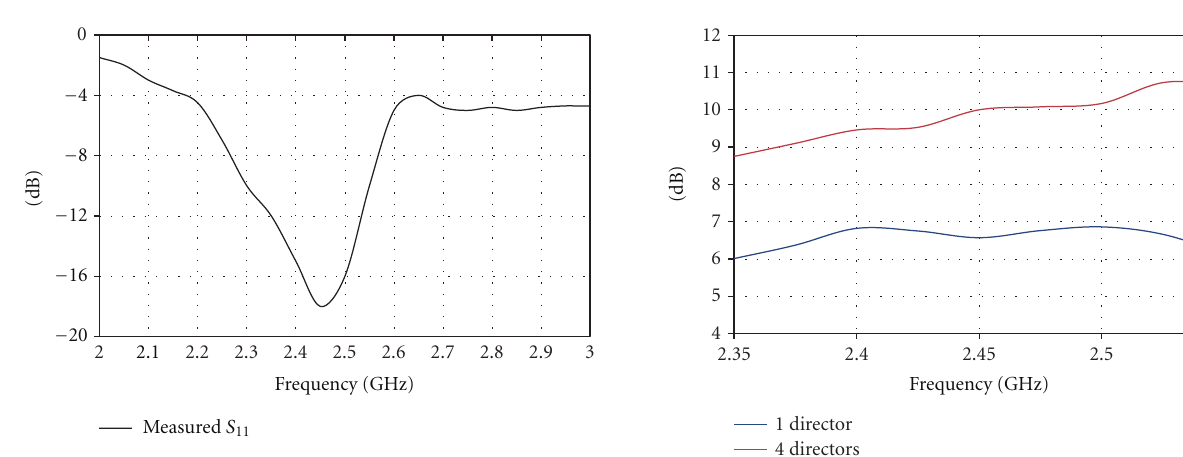
Figure 12: Measured return loss of the dipole antenna with reflector and 4 directors.